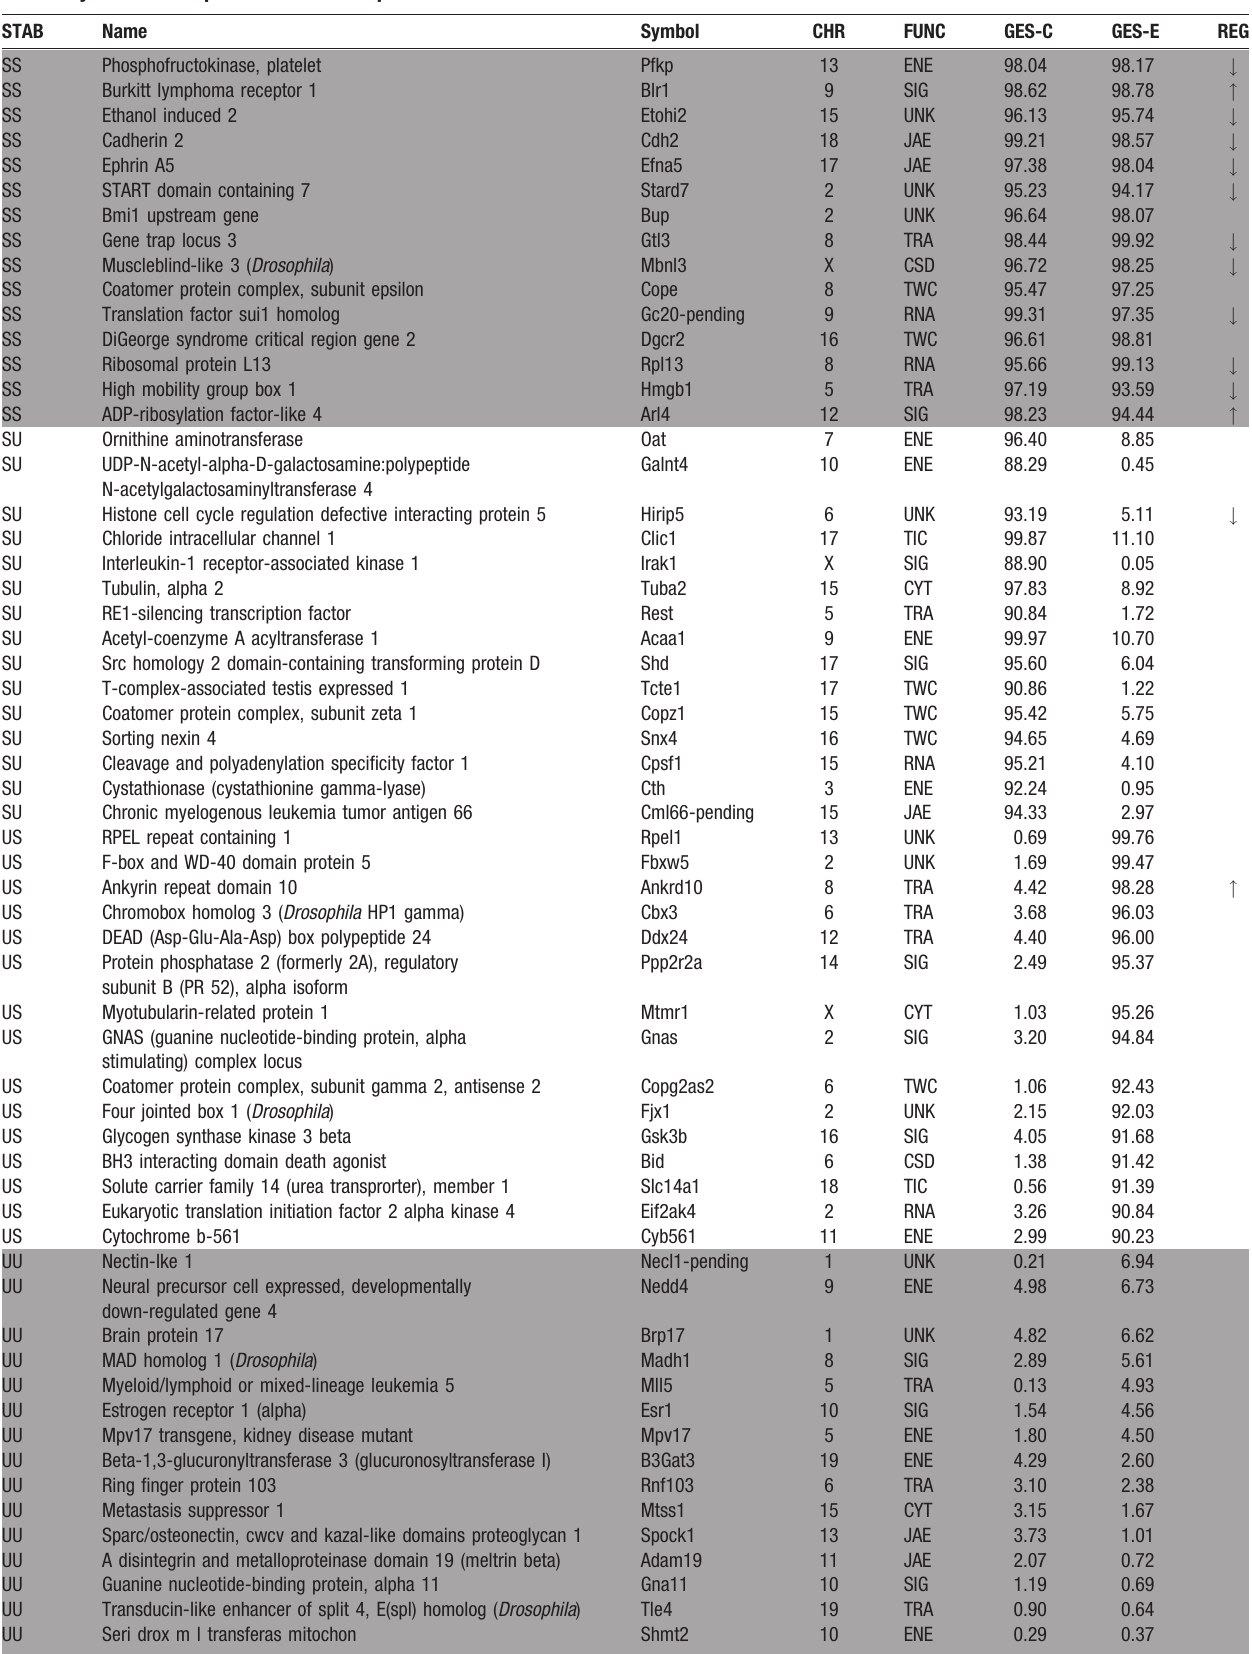
Table 3. Examples of genes that conserved (SS and UU in STAB column) or significantly changed (SU and US in STAB column) their stability or instability in AT-EAE spinal cord with respect to controls.